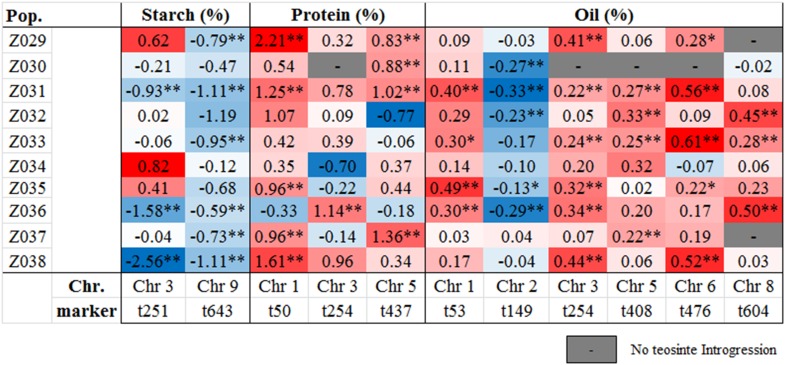
Heat map displaying additive effects of teosinte alleles across 10 populations for starch, protein, and oil content QTL relative to B73. The NIL population is indicated on the vertical axis and marker genotype associated with the QTL is indicated on the horizontal axis. Color and intensity reflect the direction and strength of the allelic effect: red represents teosinte alleles that increase the trait value and blue represents teosinte alleles that decrease the trait value. *, significant at P = 0.05; **, significant at P = 0.01; –, no teosinte introgression available for t-test.